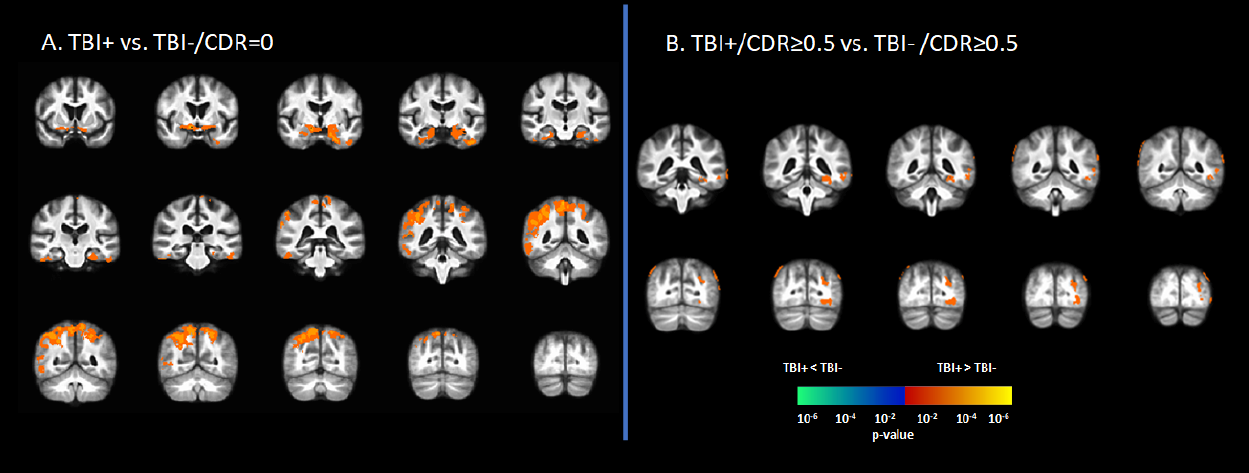
Figure 1. Differences in tau deposition to [ 18 F]-AV1451 PET between participants with self-reported history of traumatic brain injury (TBI+) and those without TBI history (TBI-). ( A ) The statistical difference map of [ 18 F]-AV1451 SUVr between the TBI+ group in contrast to the control group (TBI- /CDR = 0) group, showing that history of TBI increased the tau deposition in wide-spread brain regions. ( B ) The statistical difference map of [ 18 F]-AV1451 SUVr in the symptomatic cases between the TBI+/CDR ≥ 0.5 (in contrast to TBI-/CDR ≥ 0.5) showed increased tau deposition in cortical regions overlapping with those reported for Alzheimer’s disease [40,41]. The statistical tests were corrected for nuisance covariates, including age, gender, education, and APOE- ε 4 status. Red-yellow shows regions with the TBI+ group showing higher tau as compared to TBI-, while blue-green represents less tau deposition in the TBI+ as compared to TBI-.